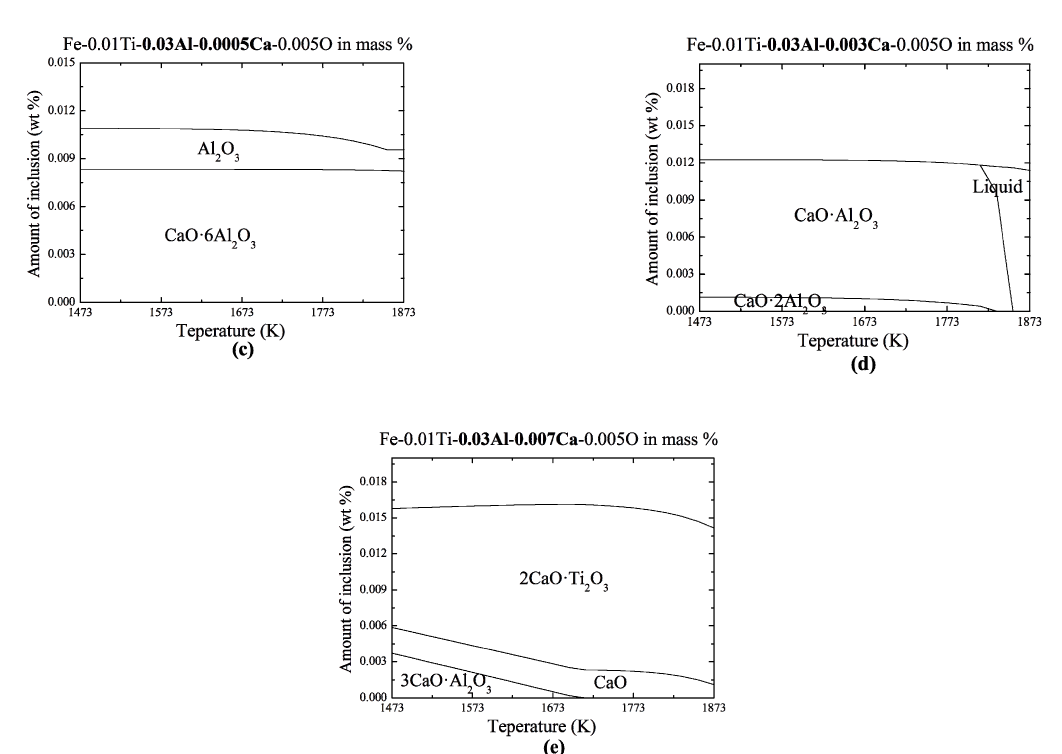
Figure 7. Transformation of inclusions during solidification as different compositions of steel. ( a ) [Al] = 0.005%, [Ca] = 0.0005%; ( b ) [Al] = 0.005%, [Ca] = 0.003%; ( c ) [Al] = 0.03%, [Ca] = 0.0005%; ( d ) [Al] = 0.03%, [Ca] = 0.003%; ( e ) [Al] = 0.03%, [Ca] = 0.007%.